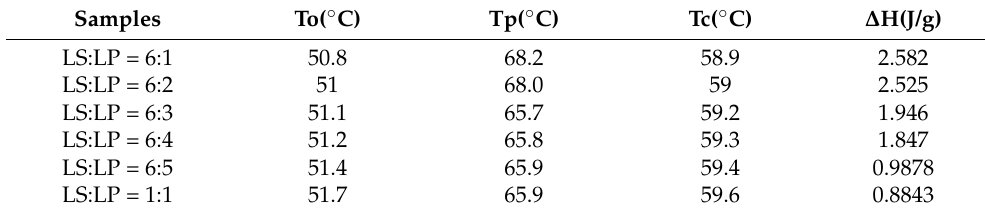
(Note: The figure displayed that lotus seed starch–protein mixture (LS-LP). LS-LP = 6:1–5 or 1:1 indicates lotus seed starch–protein with different ratios. To: onset temperature; Tp: peak temperature; Tc: cease temperature; ∆ H: gelatinization enthalpy.).